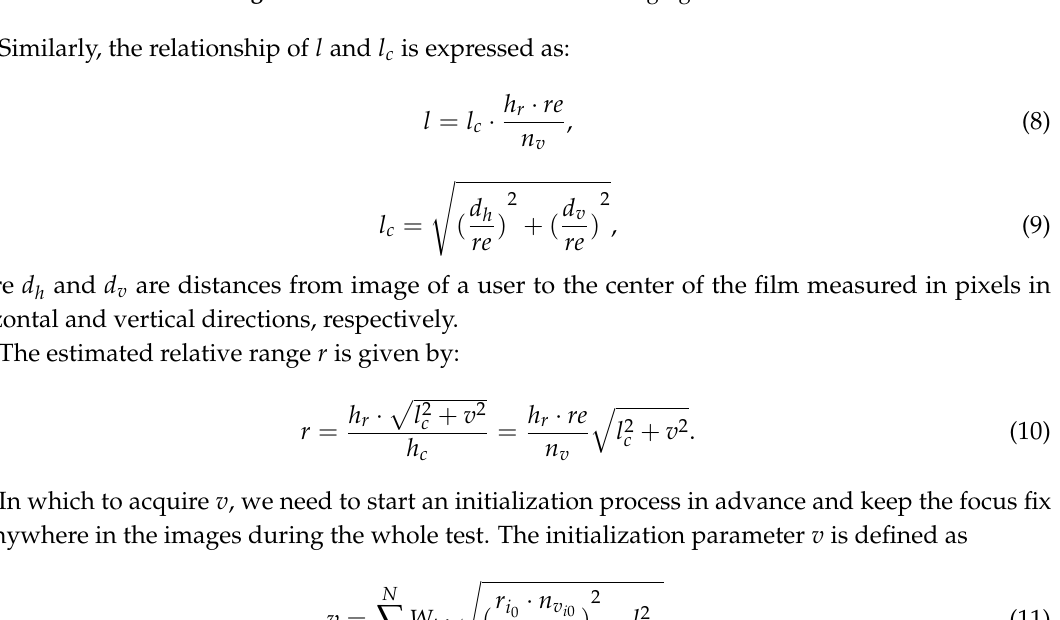
Figure 3. The monocular vision-based ranging model.